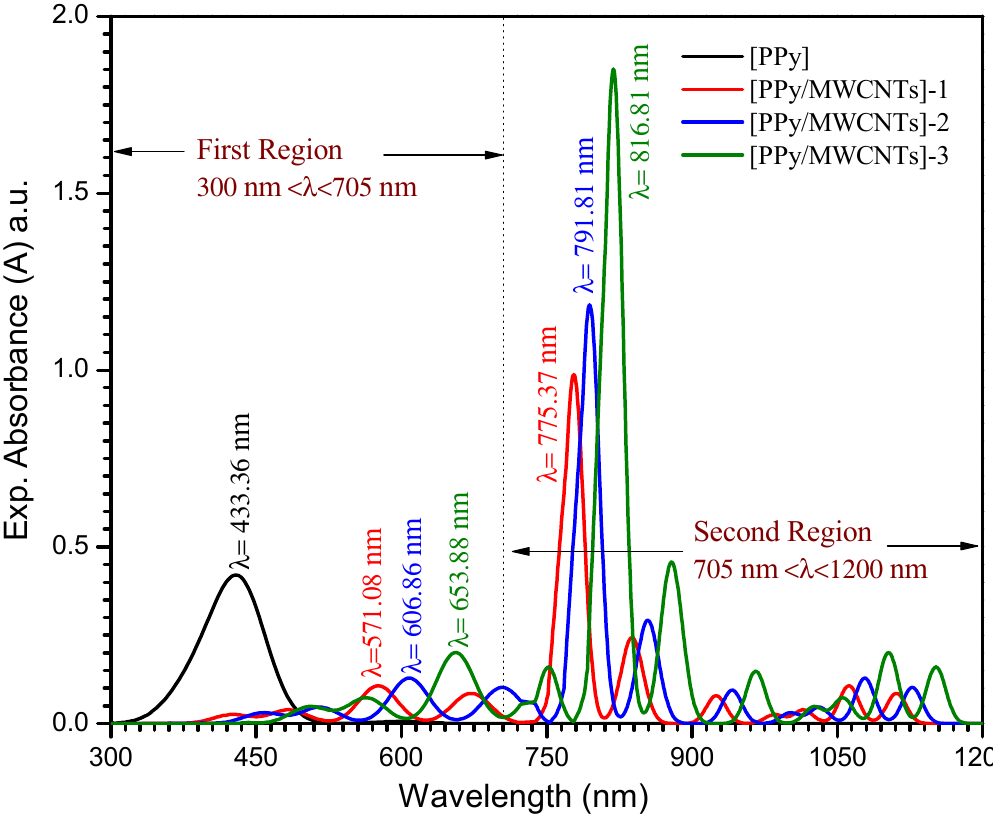
Figure 4. Spectra dependence of the absorption for [PPy/MWCNTs] 0–3 thin film as experimental part. The absorption spectrum curve Abs. ( λ ) was used to measure the band-gap energy of the [PPy/MWCNTs] composites nanocomposite thin film. Tauc’s interaction is used to evaluate the values of ( α h ν ) A as